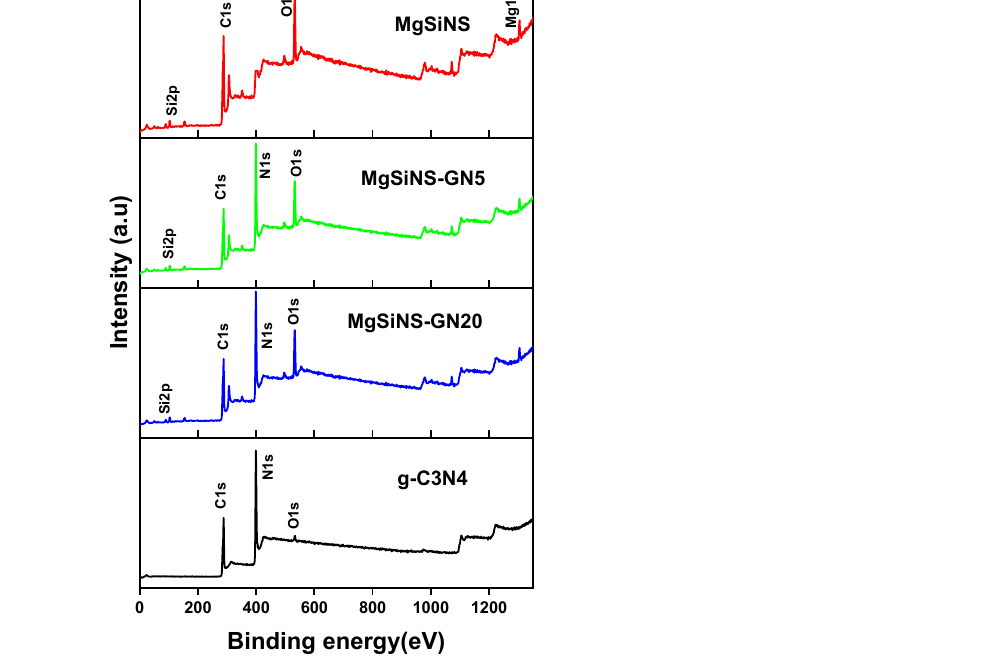
Figure 5. Full survey XPS spectra for bulk MgSiNS, g-C 3 N 4 , and two selected nanocomposites.